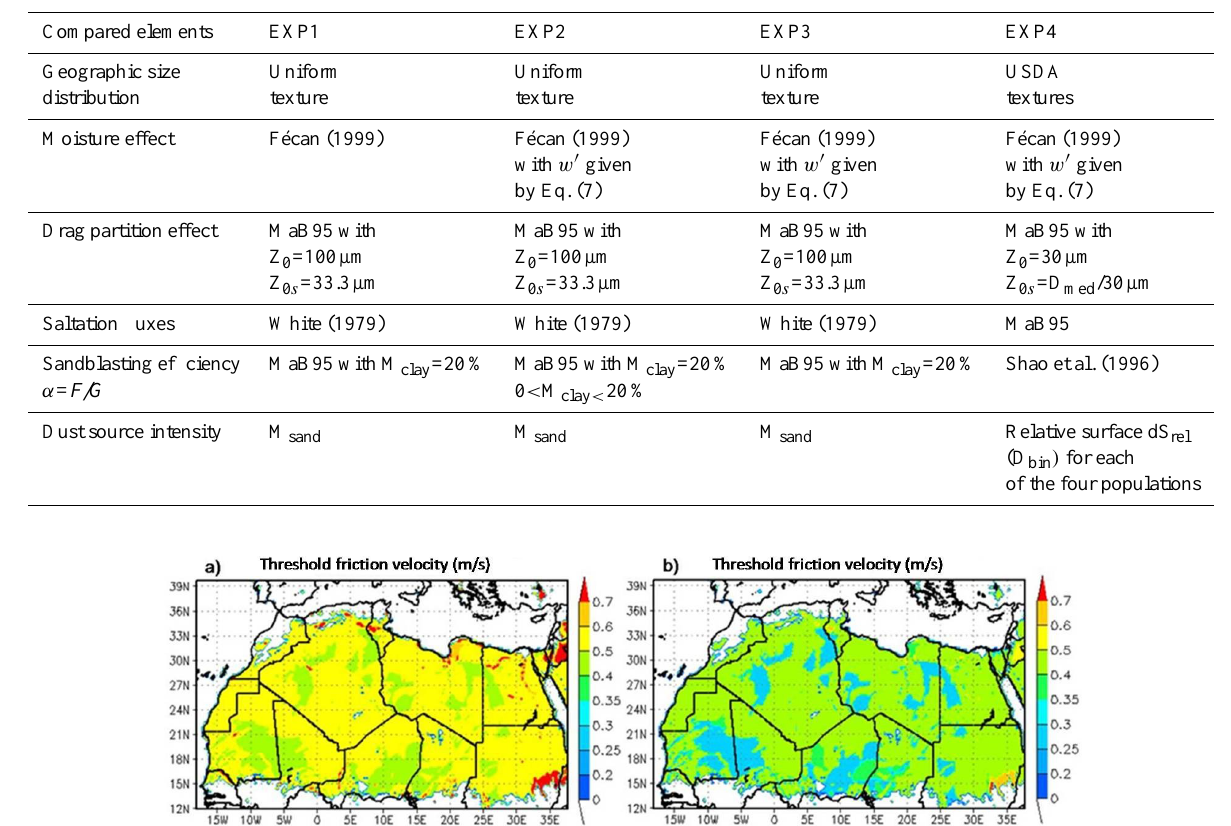
Table 4. Definition of the four configurations tested for five types of soils.